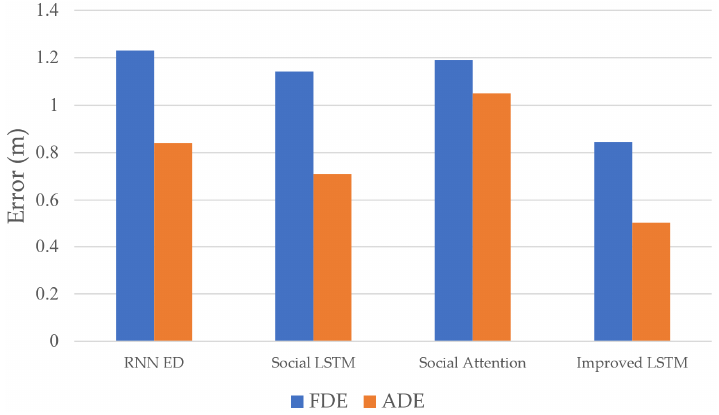
Figure 12. Performance of the improved LSTM model under FDE and ADE evaluation metrics.